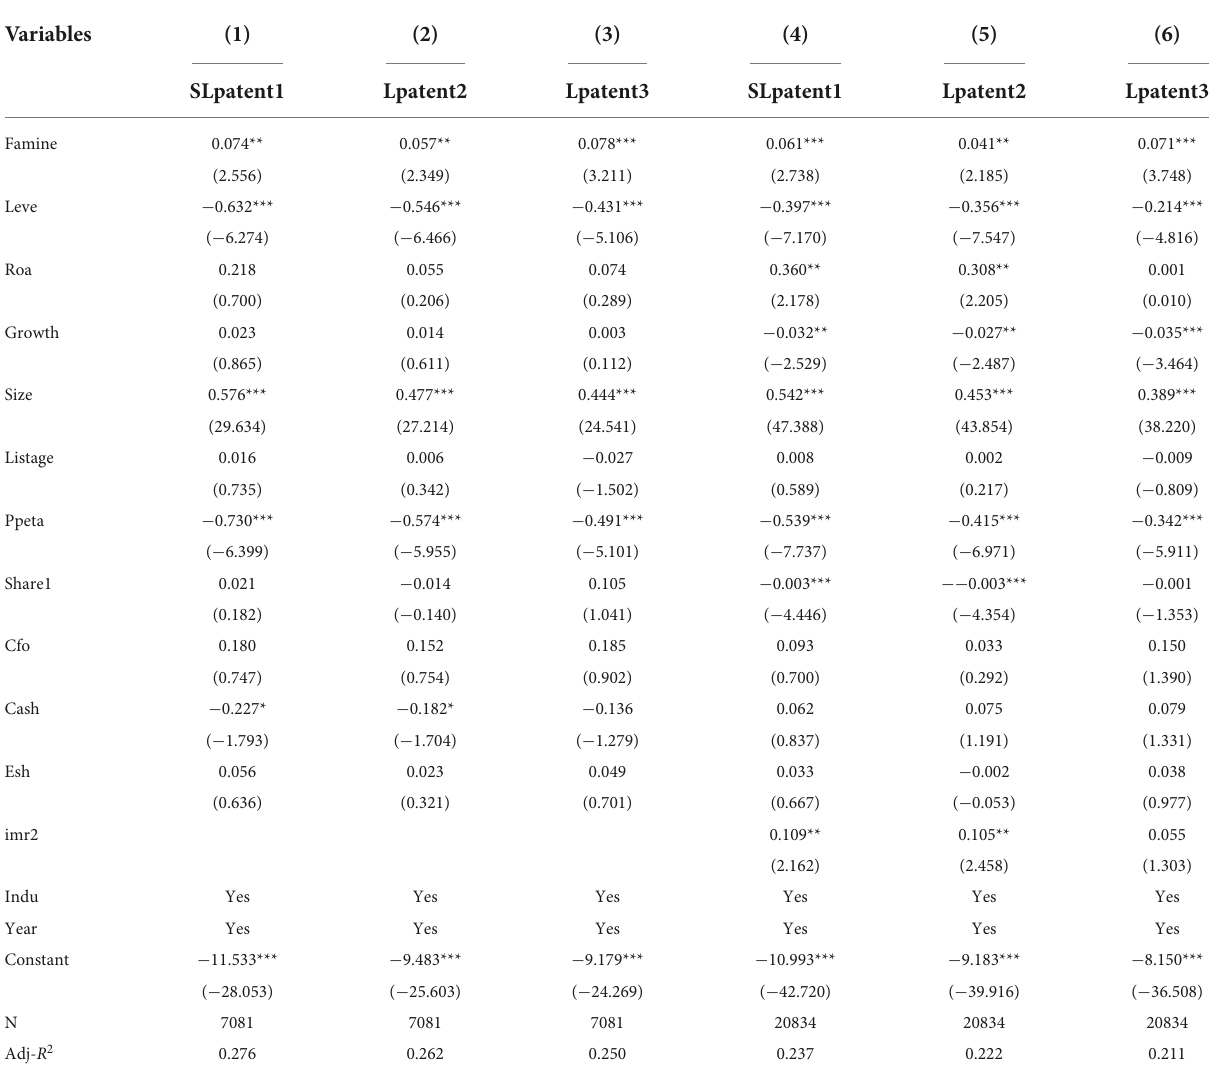
TABLE 8 PSM test and Heckman two-stage test regression